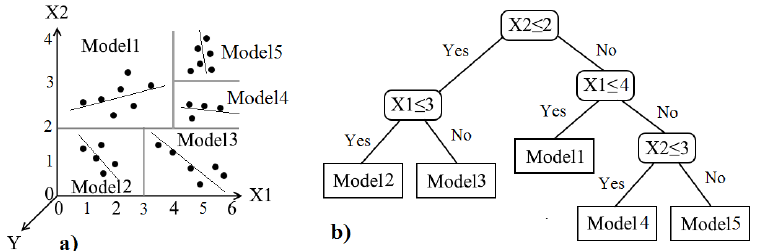
Figure 4. Basic sketch for the M5 tree model; ( a ) splitting the input vector into subsets, ( b ) M5 tree structure.